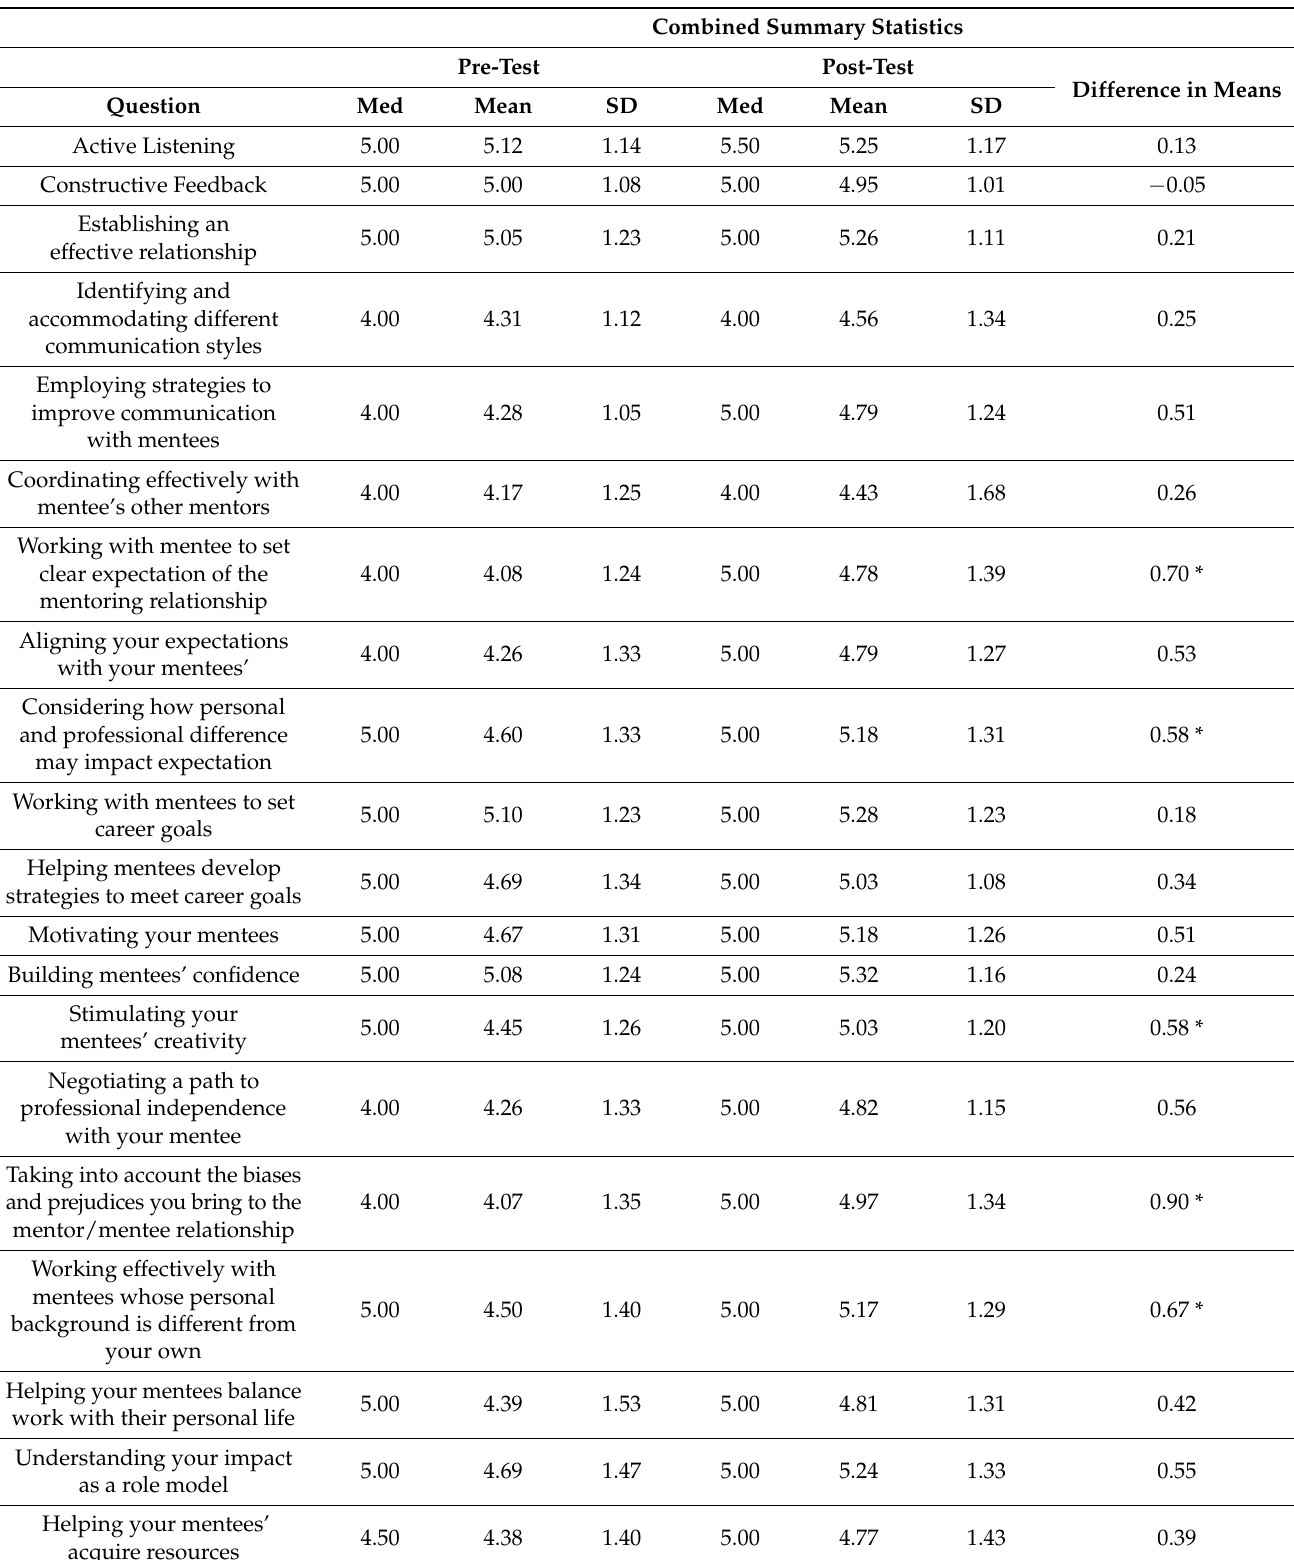
Table 2. Summary statistics for baseline and post-workshop